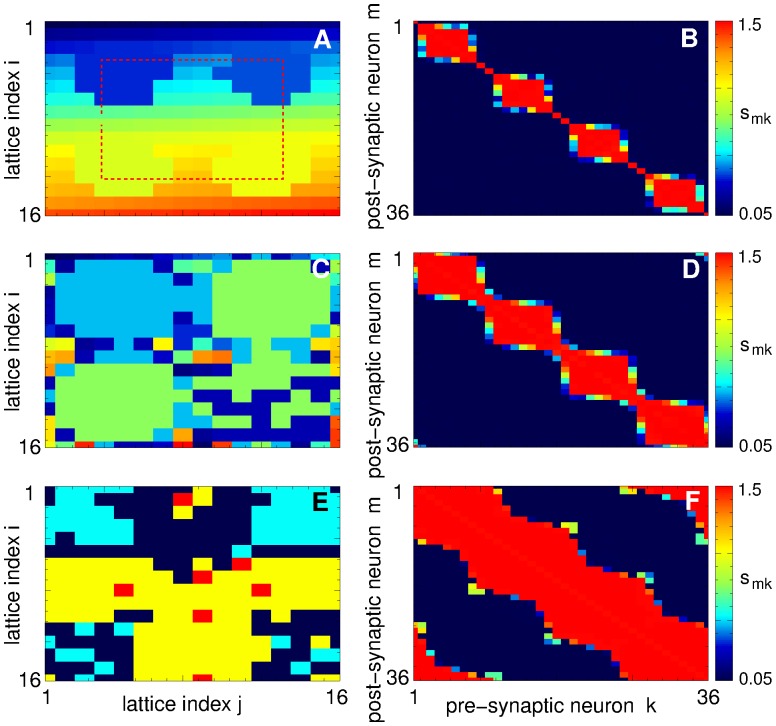
Coupling clusters induced in the neuronal ensemble with STDP (1) by CR stimulation.(A), (C), (E) 2Dim lattices of 16 × 16 neurons, where different colors depict different coupling clusters established (A) during the stimulation and (C), (E) in the post-stimulation regimes. (B), (D), (F) Individual synaptic weights s
mk evolving during CR stimulation among neurons labeled along the 1Dim section of the neuronal lattice, see Fig. 1A (dashed red curve) and text for details. Values of s
mk are encoded in color, see attached color bars. Stimulation intensity (A), (B) c = 0.95, (C), (D) c = 1.25, and (E), (F) c = 2.75.